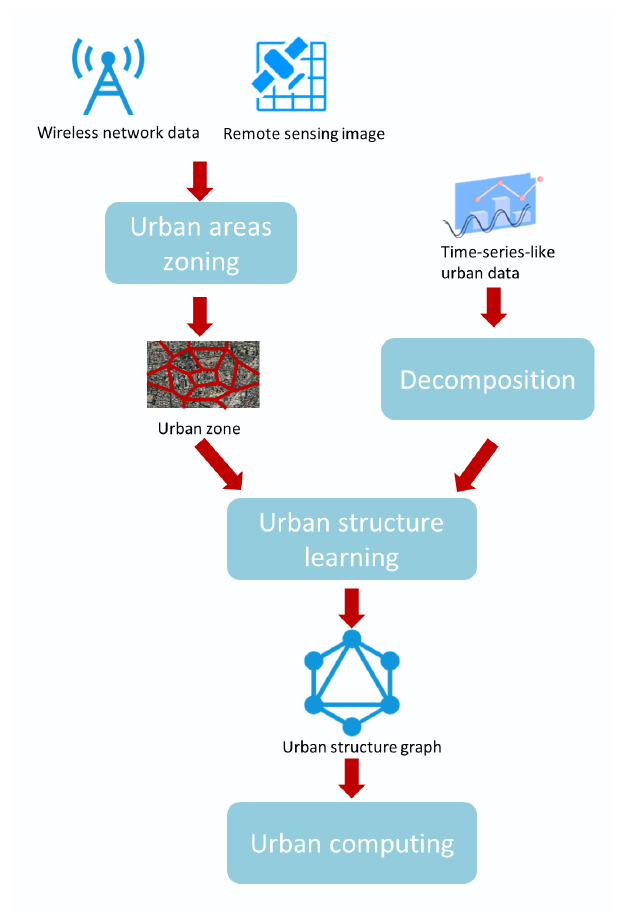
Figure 4. General process of proposed